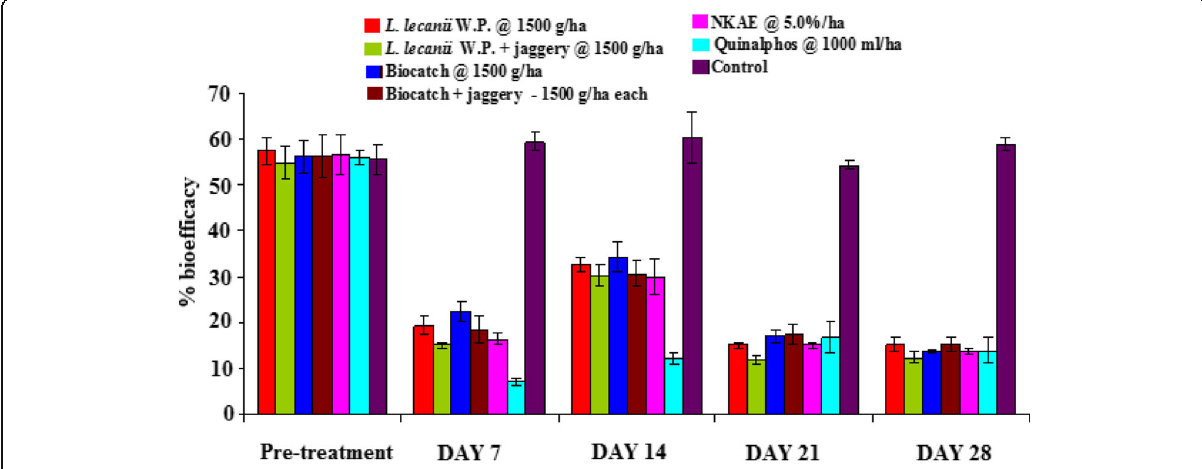
Fig. 5 Micro plot field trial on Lecanicillium lecanii against tea thrips Stethorus bispinosus